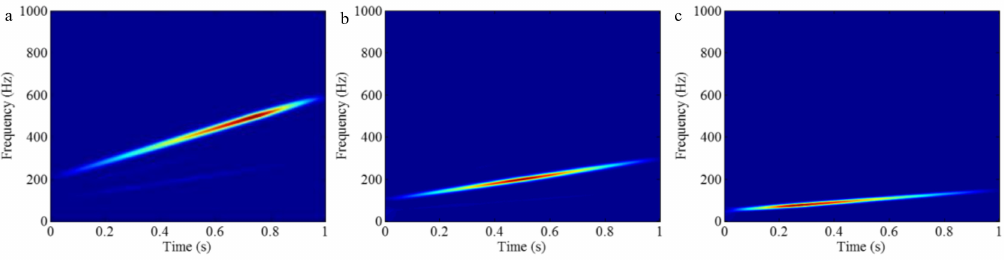
Figure 38. The STFT representations of the IMFs 1–3: ( a ) IMF 1; ( b ) IMF 2; and ( c ) IMF